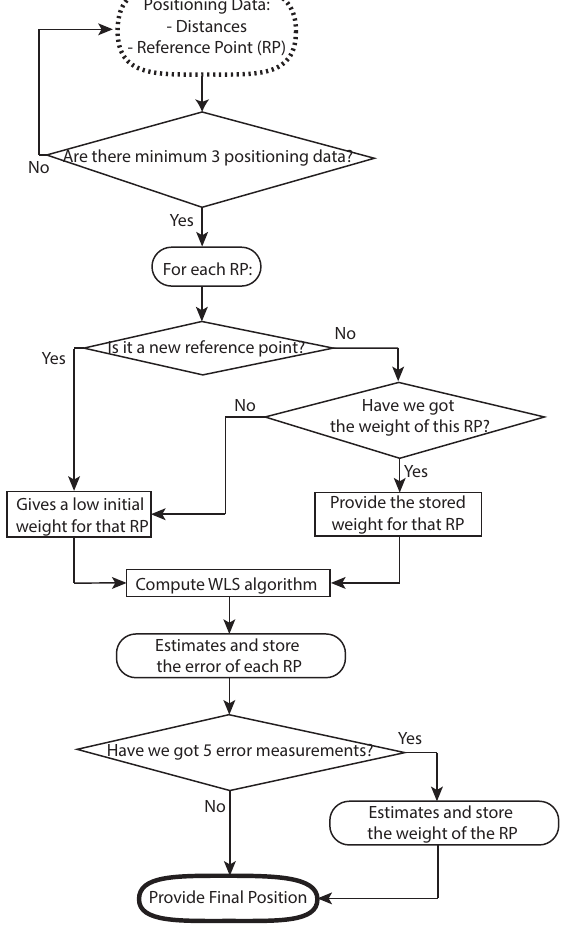
Figure 1. Flowchart of the